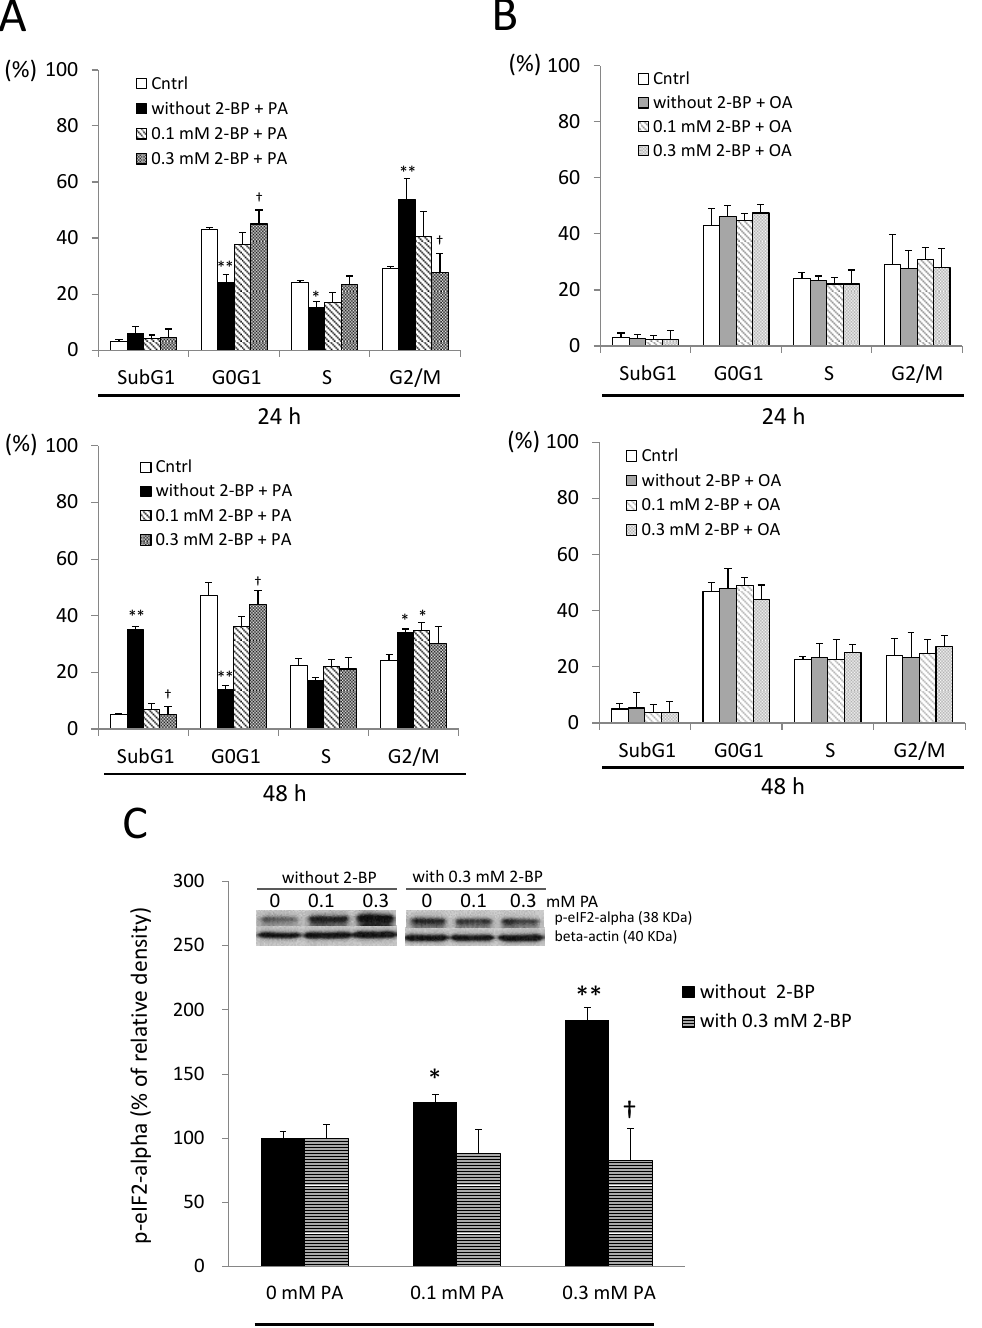
Figure 7. Effects of a protein palmitoylation inhibitor on palmitic acid (PA)-induced cell cycle disturbance and endoplasmic reticular (ER) stress. ( A ) SH-SY5Y cells were treated with the vehicle (Cntrl) and 0.3 mM PA with or without 2-bromopalmitate (2-BP) for 24 and 48 h, and then, the cell cycle was examined by flow cytometry; ( B ) SH-SY5Y cells were treated with the vehicle (Cntrl) and 0.3 mM OA with or without 2-BP for 24 and 48 h, and the cell cycle was examined by flow cytometry; ( C ) effects of a protein palmitoylation inhibitor on ER stress in PA-treated SH-SY5Y cells at 24 h. Data were analyzed by a one-way ANOVA, followed by the LSD test, and are presented as the mean ± SD. * p < 0.05, ** p < 0.01 vs the Cntrl; † p < 0.05 vs groups with PA without 2-BP. ( n =